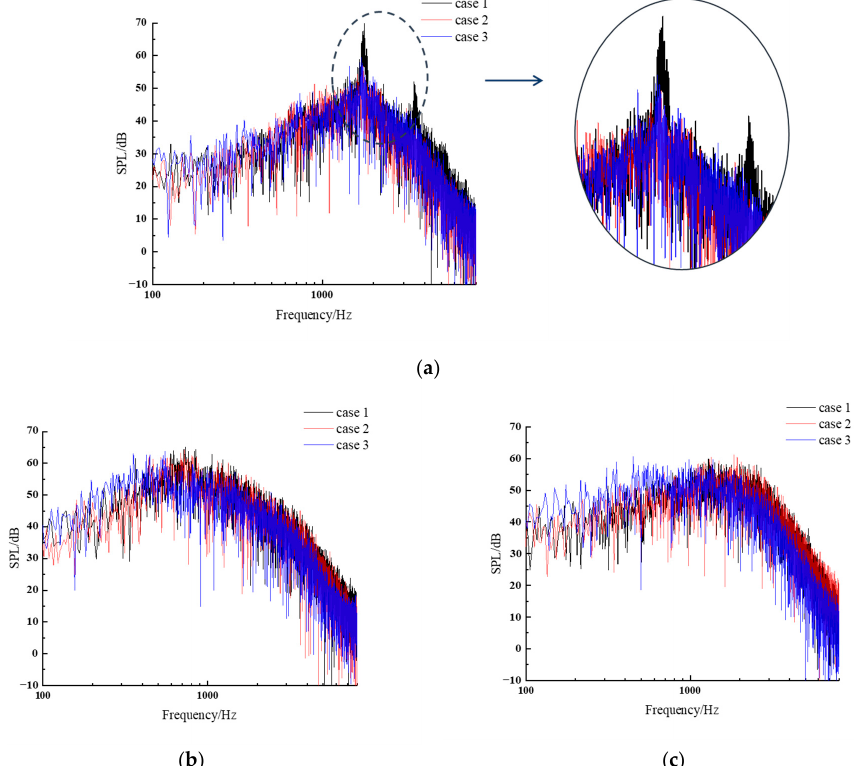
Figure 14. Noise spectra of different parts. ( a ) Panhead; ( b ) lower arm rod; ( c ) base frame.